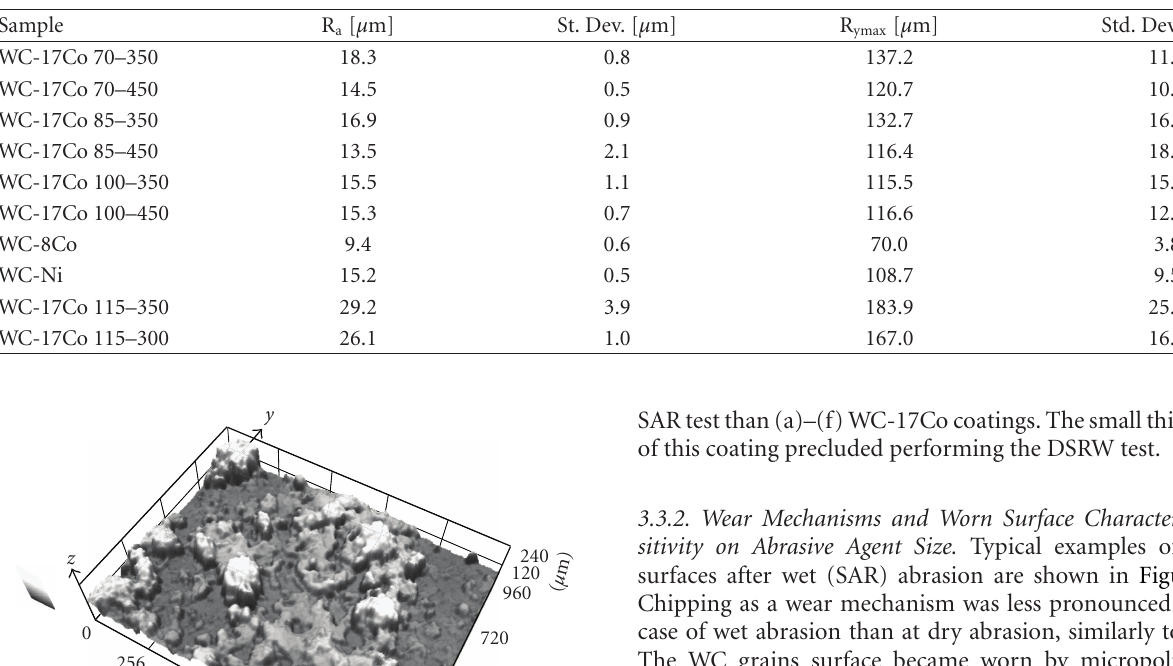
Figure 8: (a) Surface of as-sprayed WC-17Co coating 85–350; SEM. (b) Cross section of 85–350; light microscopy. Table 2: Surface roughness of WC-based coatings.